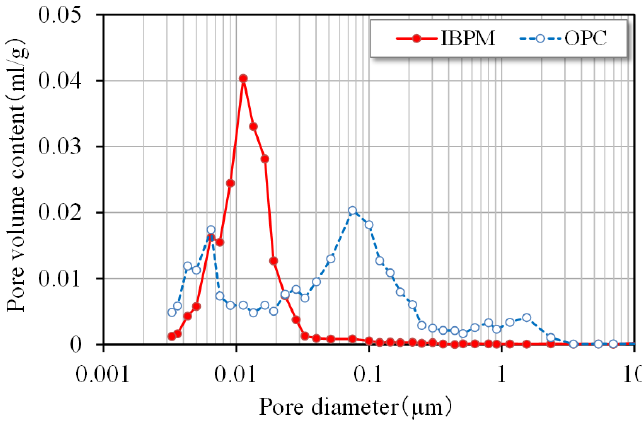
Figure 6. Pore size distributions at 14 days.